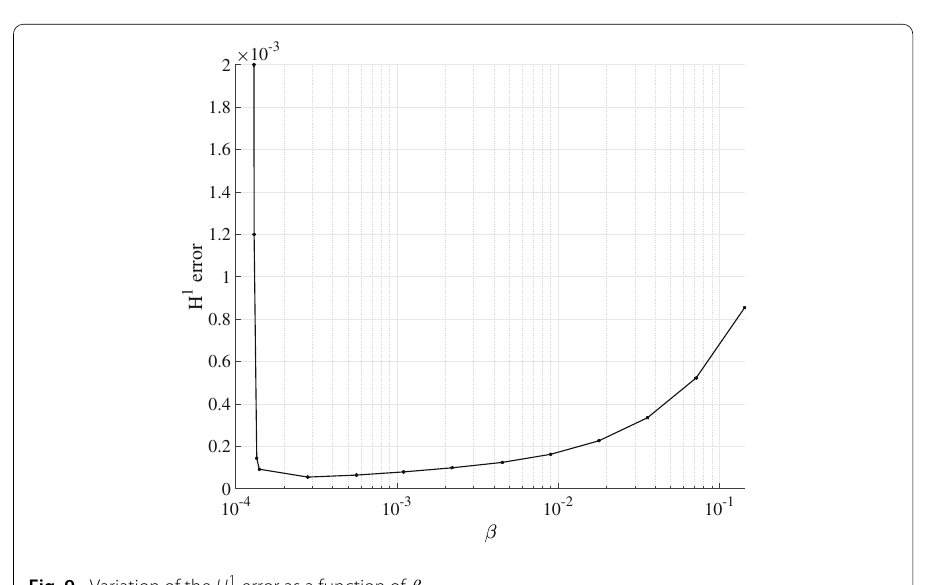
Fig. 9 Variation of the H 1 error as a function of β